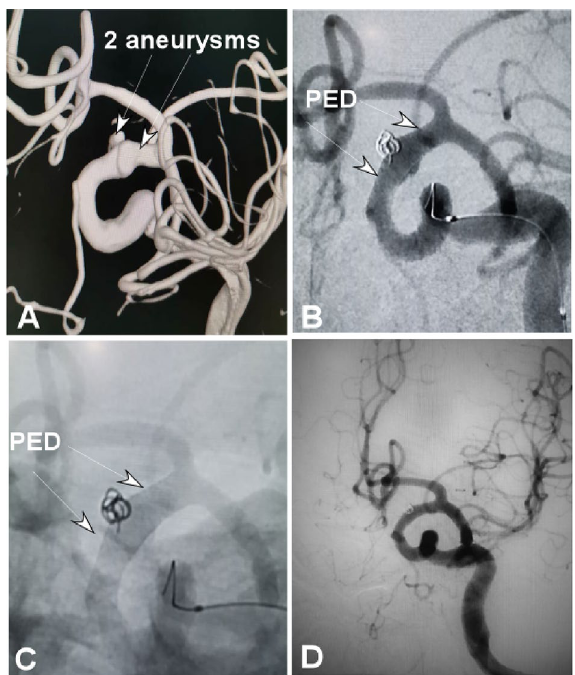
Figure 2. A middle-aged women had headache. ( A ) Three-dimensional imaging revealed two small aneurysms at the C6-7 segments of the left internal carotid artery growing in two different dirrections. ( B ), ( C ).